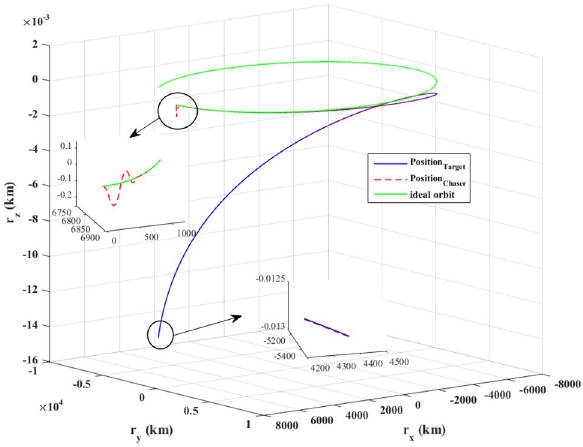
Figure 49. Scenario II: target’s and chaser’s motion path VS target’s ideal orbit (5000 s).